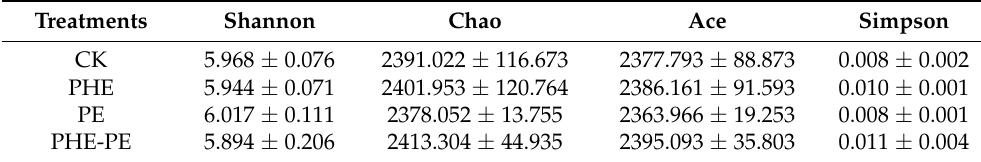
Table 3. Compared with the CK, no significant difference in Shannon, Chao, Ace and Simpson indexes was observed in all treatments ( p > 0.05). Table 3. Effects of PHE and PE on the diversity of bacterial community in agricultural soils. Treatments